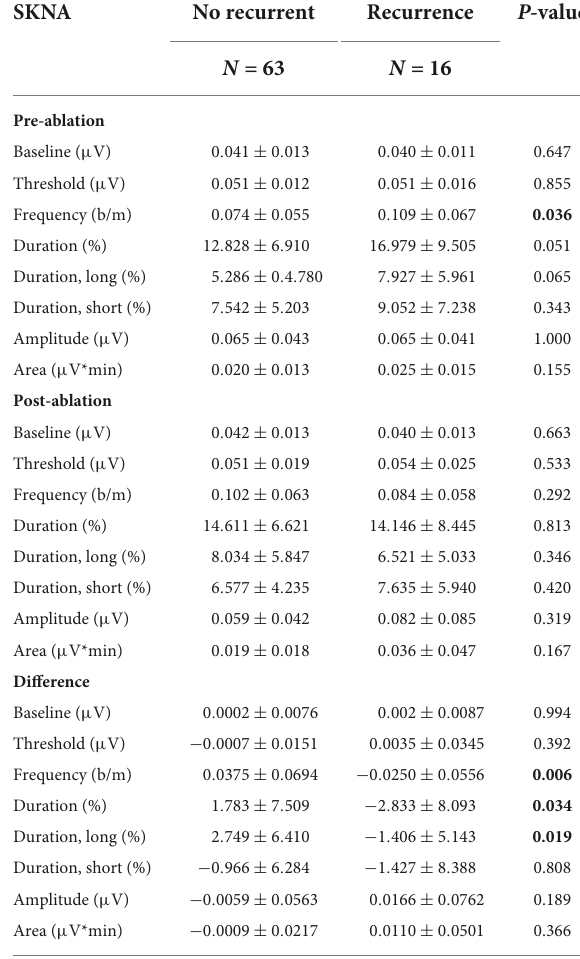
Allvaluesareexpressedasmean ± SD. SKNA:skinsympatheticnerveactivity,pleaserefertotextfordefinition. Boldvaluesmean p < 0.05.